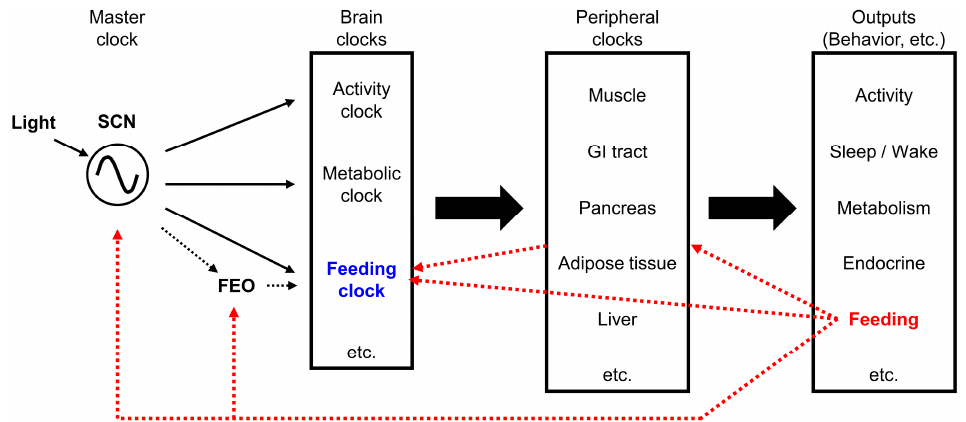
Figure 2. Biological clock systems and feeding behavior. Multiple layers of biological clocks regulate biological outputs. Red arrows indicate how feeding behavior can send feedback to the feeding clock, by affecting multiple levels within the system. Abbreviations: FEO, food-entrained oscillator; SCN, suprachiasmatic nucleus of the hypothalamus.